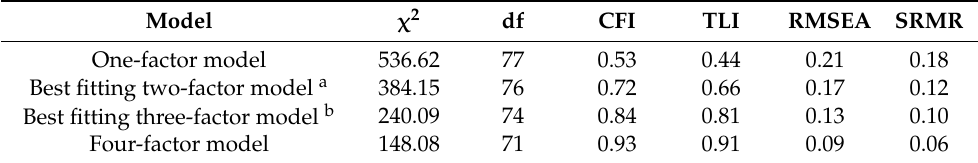
Table 3. Goodness-of-Fit